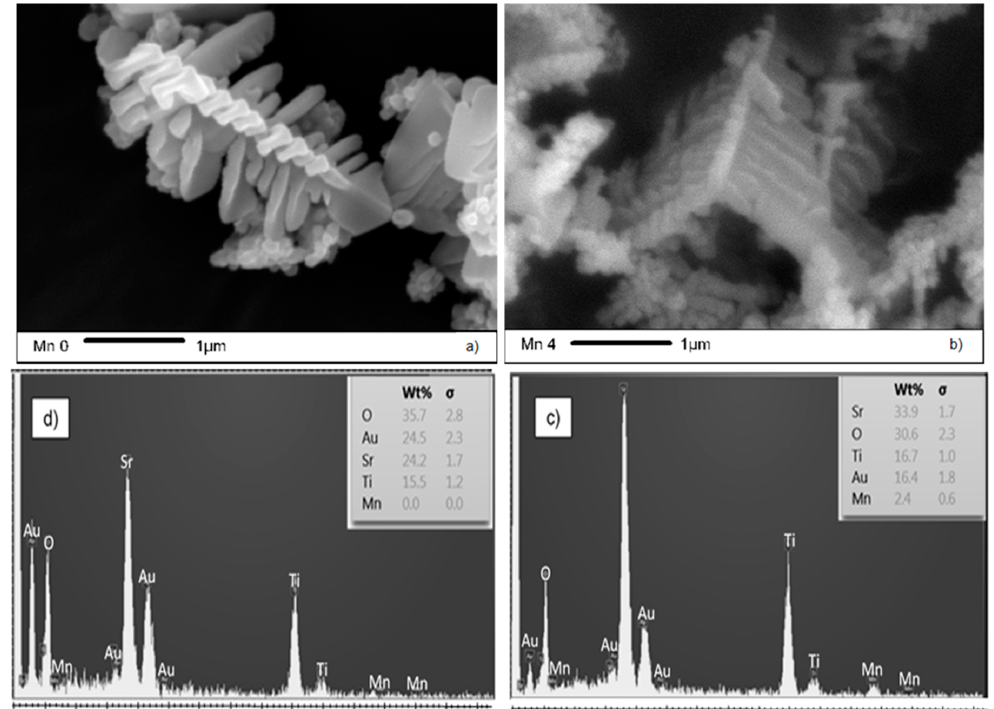
Figure 2. ( a ) Mn0 and ( b ) Mn4 SEM images of catalysts with dendritic morphology; ( c ) Mn4 and ( d ) Mn0 EDS spectra of samples synthesized in this work by hydrothermal method and calcined at 600 °C for 5